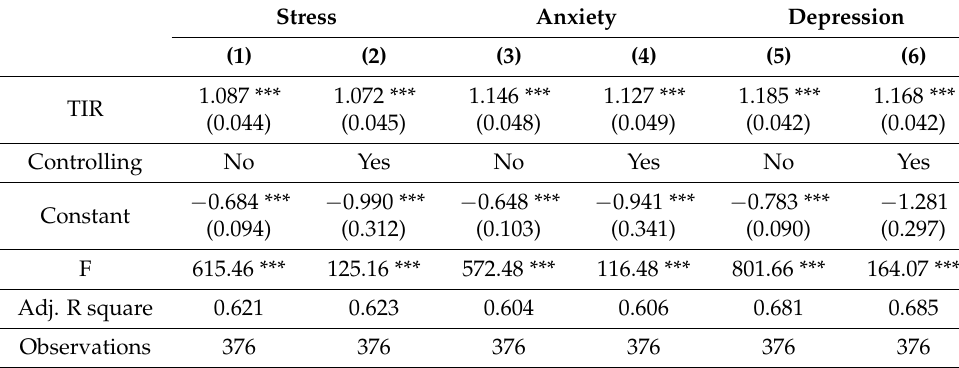
Table 5. Results of regression analyses for the main